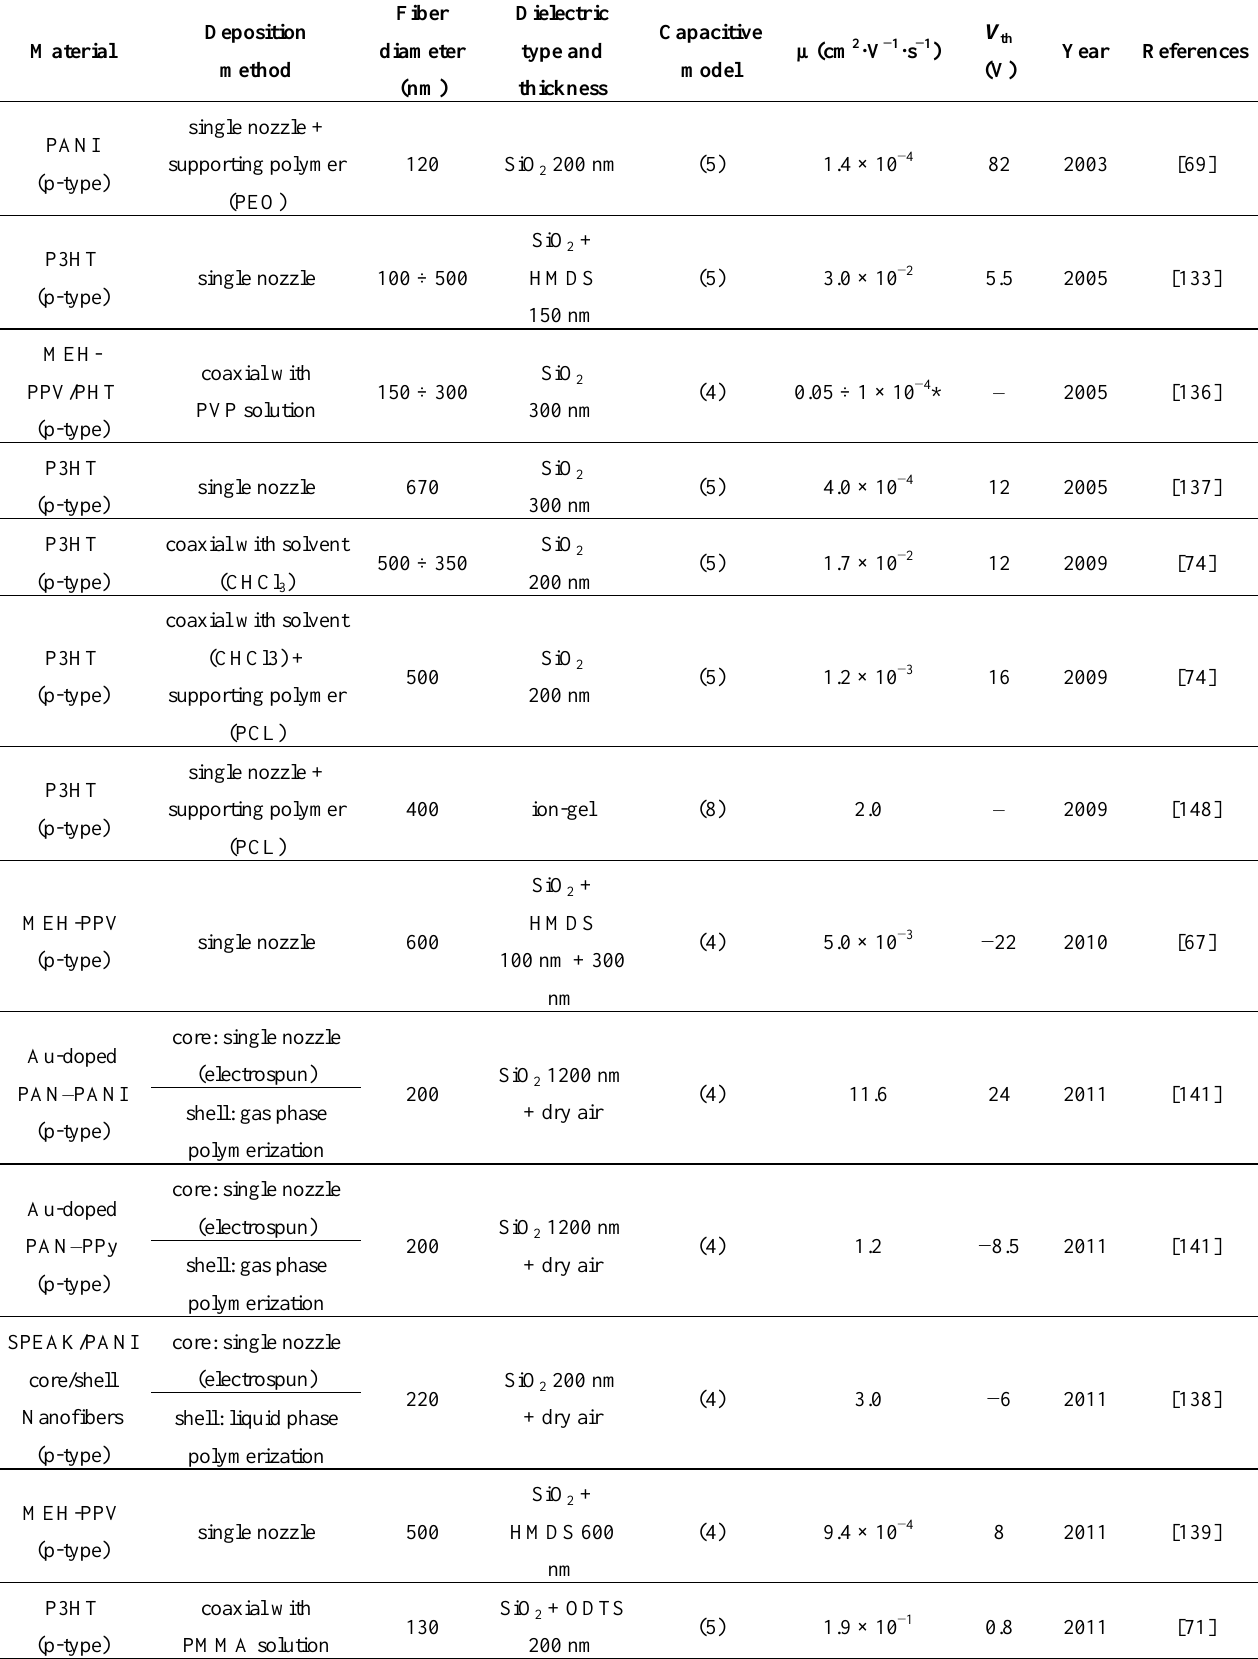
Table 2. Survey of carriers mobility achieved so far in polymer